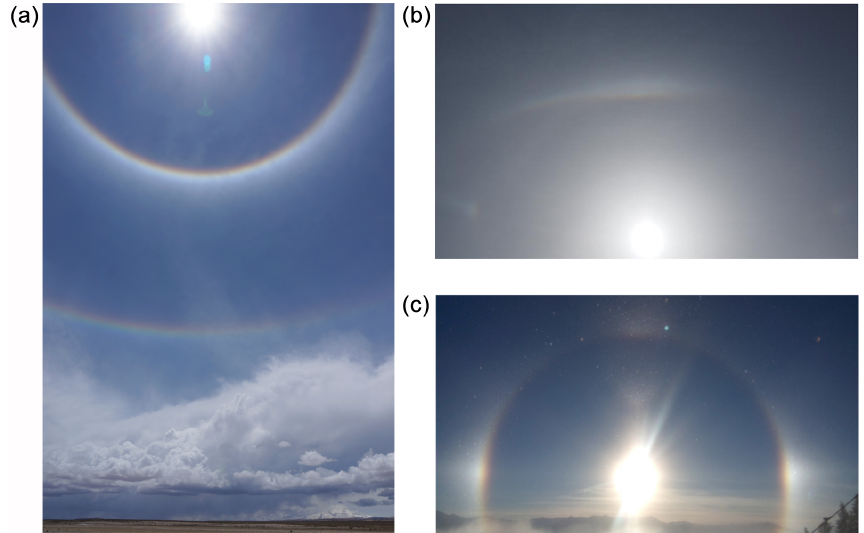
Figure 1. (a) A bright 22 ◦ halo or circumscribed halo with infralateral arc below, Salar de Uyuni, Bolivia, 2 October 2014 (photograph by Leonhard Scheck). (b) Upper tangent arc with faint sundogs in Munich, Germany, 1 April 2014. The halo displays are faint due to the high aerosol concentration in the air. (c) A 22 ◦ halo with upper tangent arc and bright sundogs on Mt. Hohe Salve, Austria, 18 January 2016 (photograph by Volker